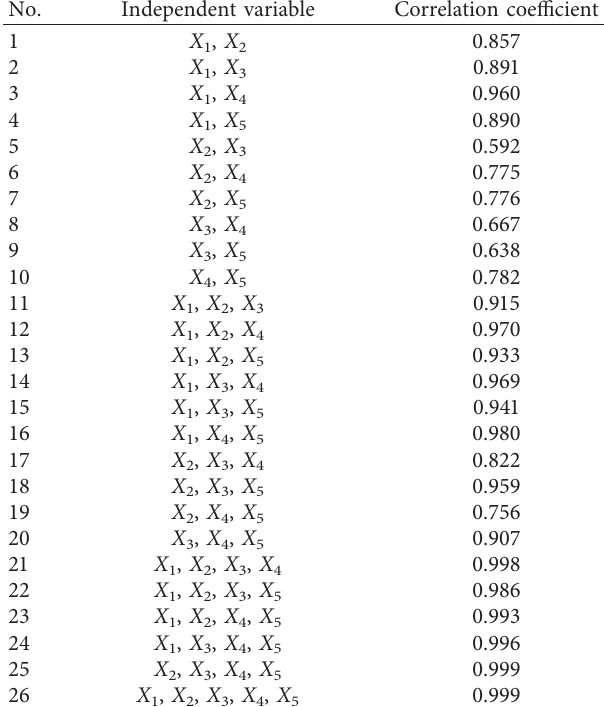
Table 3: The correlation